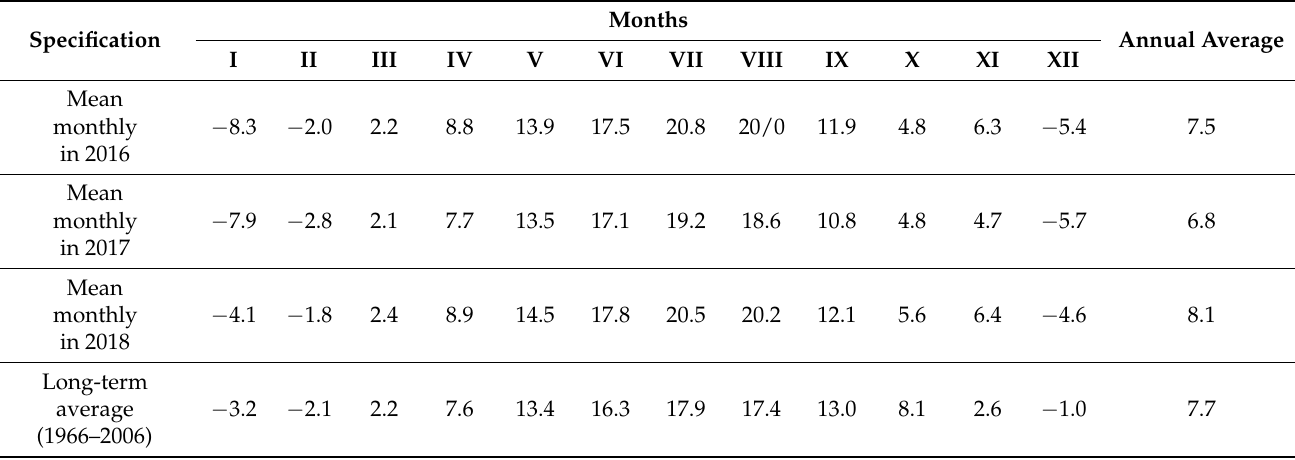
Table 4. Average air temperatures ( ◦ C) in